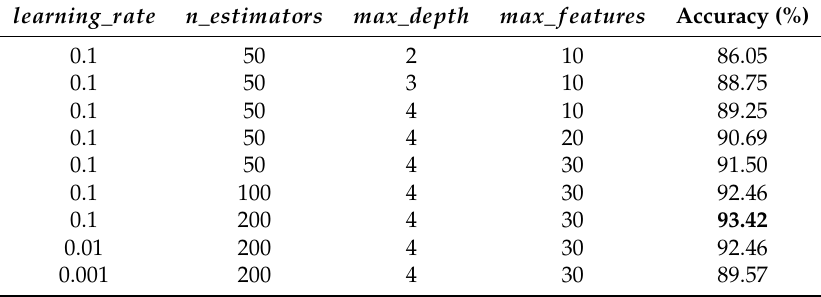
Table 7. The detailed classification results of KPCA &